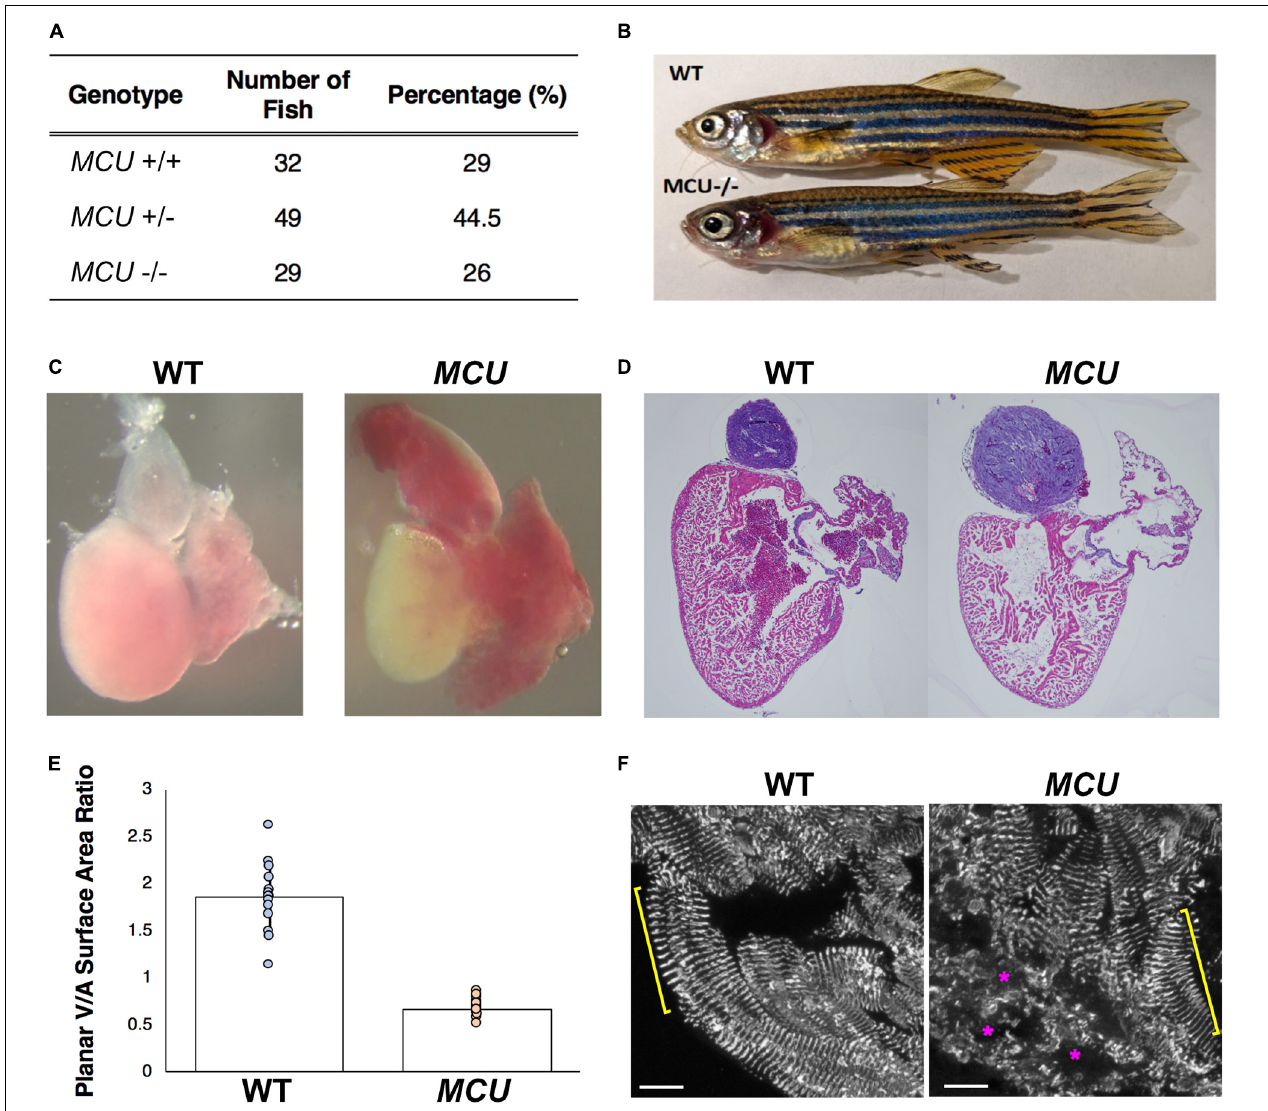
FIGURE 2 | Cardiac morphological analysis of adult MCU mutants. (A) Genotypic distribution of F1 generation from MCU heterozygous parents matches closely with Mendelian ratio and show no signs of embryonic lethality. (B) Comparable exterior phenotypic traits between wildtype and MCU mutant zebrafish. (C) Defects in cardiac structure observed in dissected adult MCU mutant hearts. Mutant hearts were characterized by enlarged atrial volume and limited ventricular blood flow. (D) Reduction in tissue density and disorganization of myocardium observed in histological sections (Hematoxylin and Eosin stains) of MCU mutant hearts. Nuclei rich regions stained blue and cytoplasmic regions and ECM stained pink. (E) Selected image frames during systolic and diastolic phases were analyzed to compare ventricular-to-atrial surface area ratio. Ventricular:atrial SA ratio were significantly reduced in MCU mutant hearts ( n = 14 for each group, p < 0.0001). (F) α -actinin staining marks the Z -lines of intact sarcomeres in ventricular cardiomyocytes of wild type adult fish (yellow bracket). Adult MCU ventricles contain regions with intact myofibrils/sarcomeres (yellow bracket), but also exhibit areas of patchy α -actinin staining indicative of damaged myofibrils and broken-down sarcomeres (magenta asterisks). Scale bars indicate 10 µ